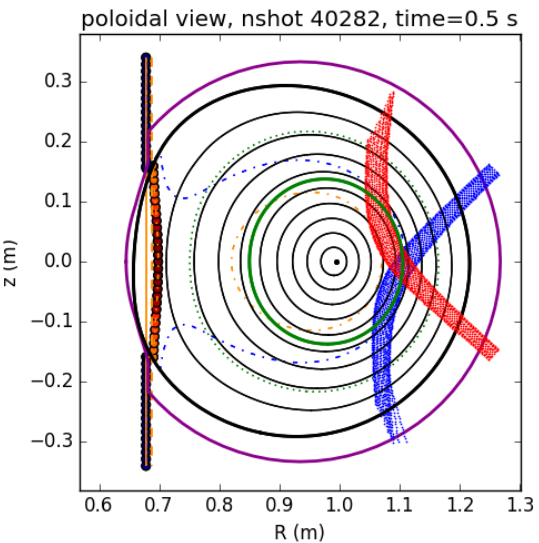
Fig. 11. Plasma equilibrium and main EC resonances for shot #40282 with symmetric launch: the probe beam (in red) and received beam intersect themselves close to the q=2 resonant surface on the equatorial plane and are refracted toward the vessel by the high-density plasma.